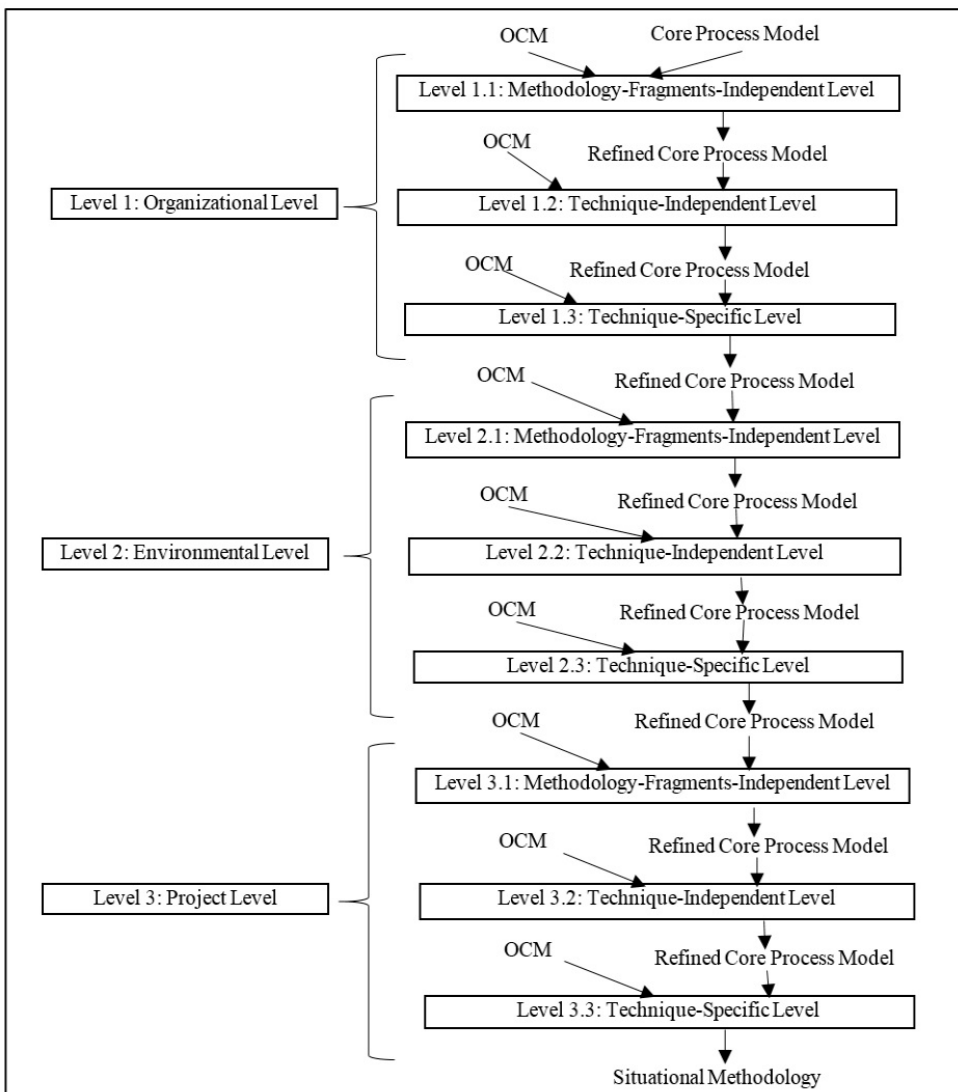
Figure 8. Modeling levels defined in the design subphase.